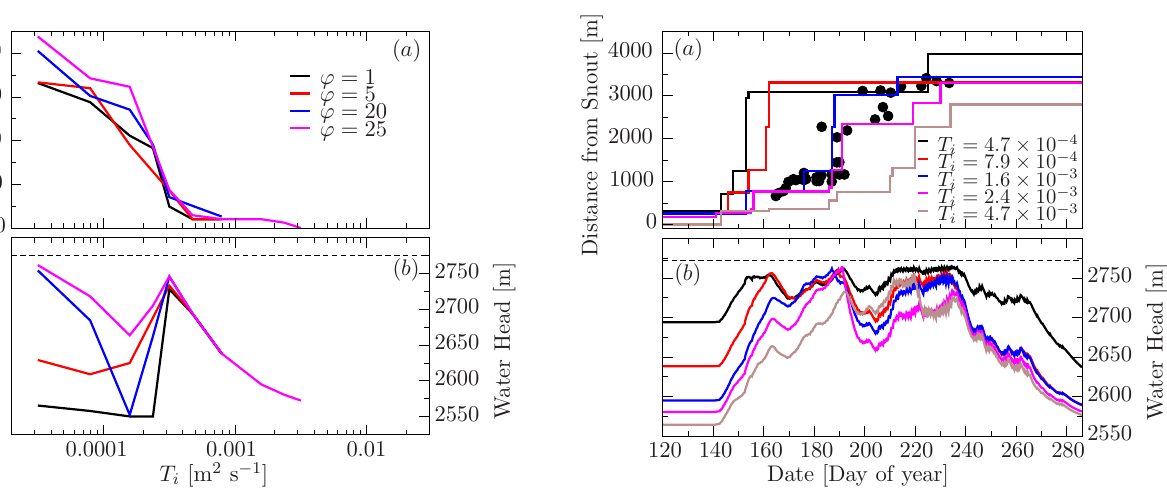
Fig. 7. Length of the EPL (a) and IDS water head in the borehole array (b) as a function of the IDS transmissivity T i for four differ- ent values of the leakage length scale ϕ and an EPL transmissivity of T e = 7 . 9 × 10 − 2 m 2 s − 1 . The dashed line in (b) represents the flotation limit.